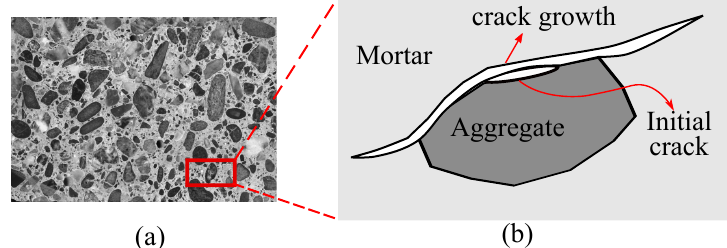
Figure 1. Schematic of single crack growth in concrete. ( a ) Schematic of concrete material; ( b ) growth of single microcrack.